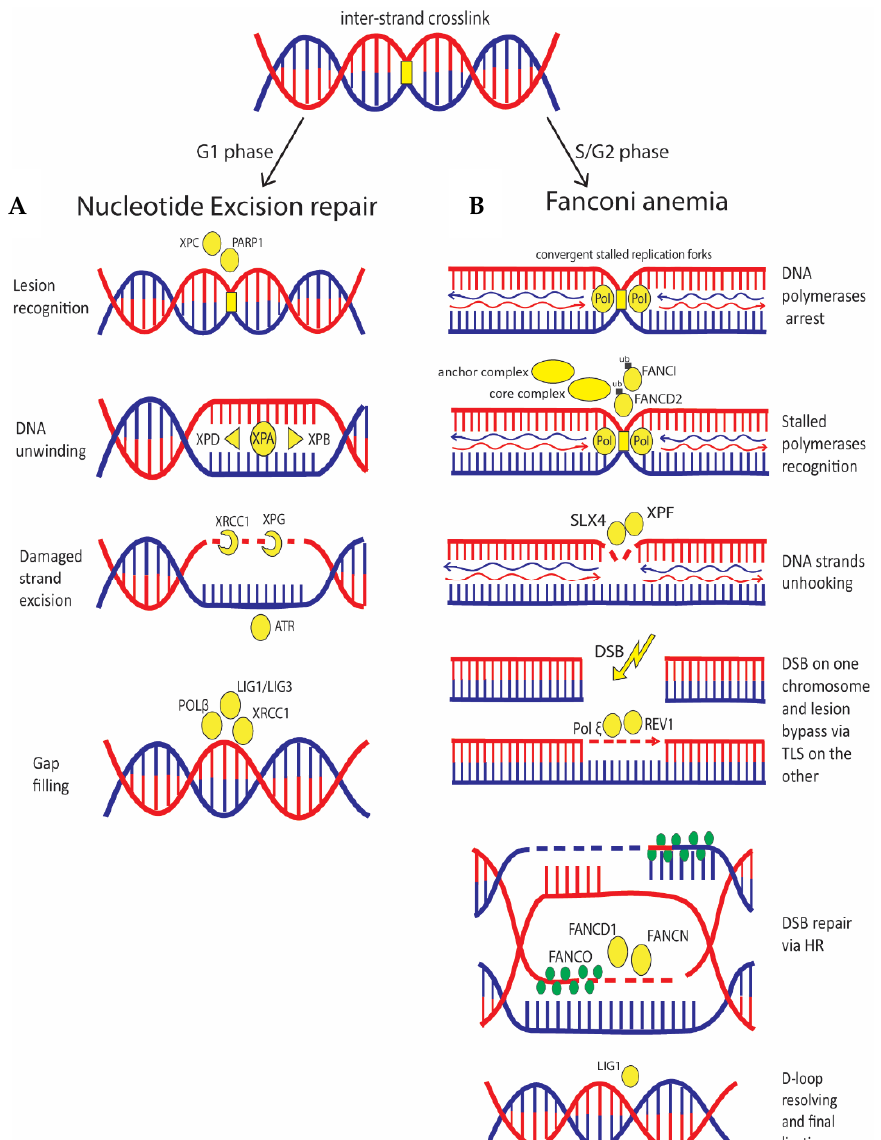
Figure 4. Bulky lesions are repaired by nucleotide excision repair, inter-strand crosslinks formed in S/G2 phase, are repaired by Fanconi Anemia pathway. ( A ) In NER, the bulky lesion is recognized by PARP1 and XPC; they recruit XPA that acts as a scaffold organizing the helicases XPB and XPD that unwind the DNA around the damage. Then, several bases are removed by ERCC-1-XPF and XPG endonuclease; the gap generated is filled by Pol-β and ligated by XRCC1, LIG3/LIG1. ( B ) Convergent arrested-replication forks are recognized by the anchor complex; this recruits the core complex which attaches a single ubiquitin residue to FANCI and FANCD2. After, SLX4 and XPF nucleases unhook the DNA strand determining a DSB on one strand. The strand without the DSB is repaired by TLS by Pol ξ assisted by REV1; the other strand is repaired via HR by FANCS (BRCA1), FANCD1 (BRCA2), FANCN (PALB2) and FANCO (RAD51).